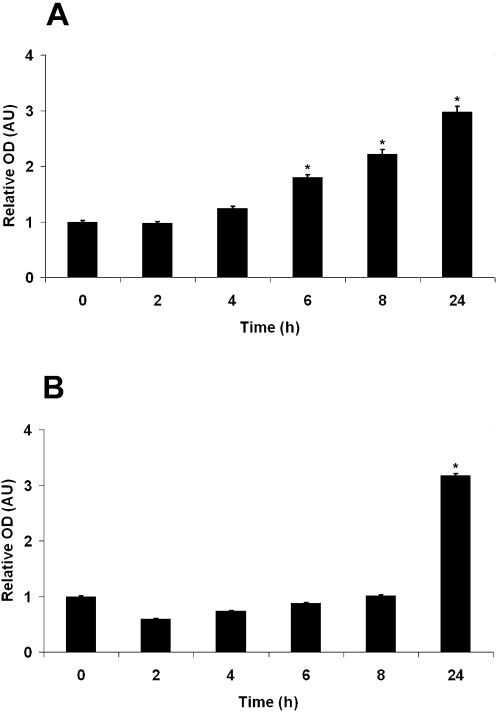
Cytokine and Chemokine Induction by MG.MH-S cells were treated with 0.8 mM MG.TNF-α and CXCL10 concentrations in the culture medium were measured at various time points as indicated on the X axis.Relative OD values were calculated by setting the OD value to 1 at time 0 h.A significant increase of TNF-α (A) and CXCL10 secretion (B) was observed after MG treatment of MH-S cells.This confirms the results of microarray experiments.Error bars represent±SD.Statistical significance was determined by Student's t test; *, P<0.05 for MH-S cells treated with MG (6, 8, and 24 h after treatment for TNF-α and 24 h after treatment for CXCL10) versus untreated MH-S cells.